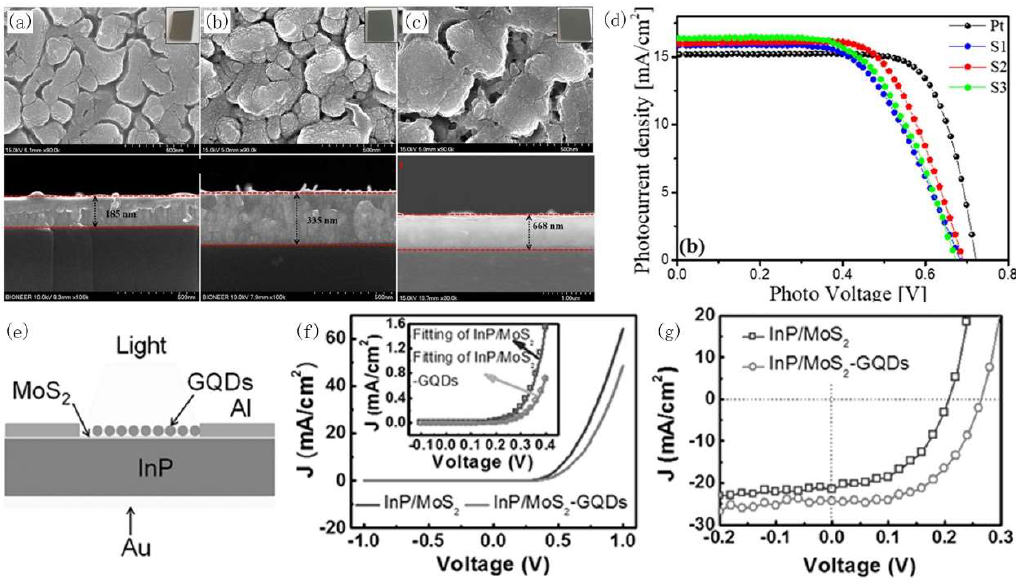
Figure 8. Image of TMDC-based solar cell. ( a – c ) Topological and cross-sectional SEM image and ( d ) photo current versus voltage of MoTe 2 solar cell [170]; ( e ) Schematic structure and current density versus voltage (J-V) curve of MoS2/InP solar cell with and without graphene quantum dots ( f ) under dark conditions and ( g ) under AM 1.5G illumination [166].